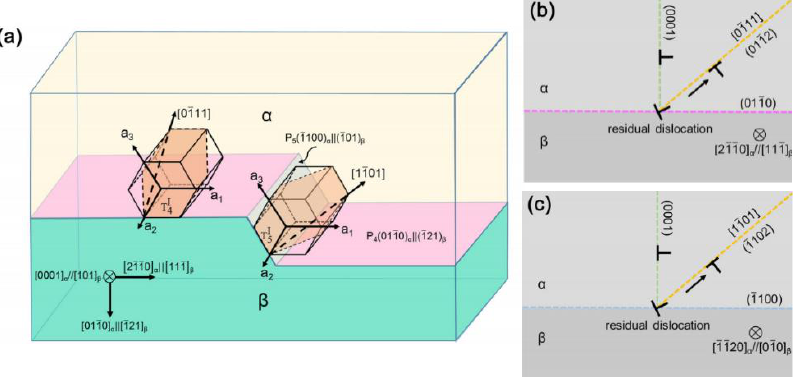
Figure 12. Schematic of the twinning nucleation mechanism from <a> type dislocations dissociation ( a ) schematic of reaction of basal <a> type dislocations at different planes into different twin dislocations and residual dislocations; ( b ) dissociation of a 2 and a 3 dislocations at terrace plane; ( c ) dissociation of a 2 dislocation at ledge plane. [97].